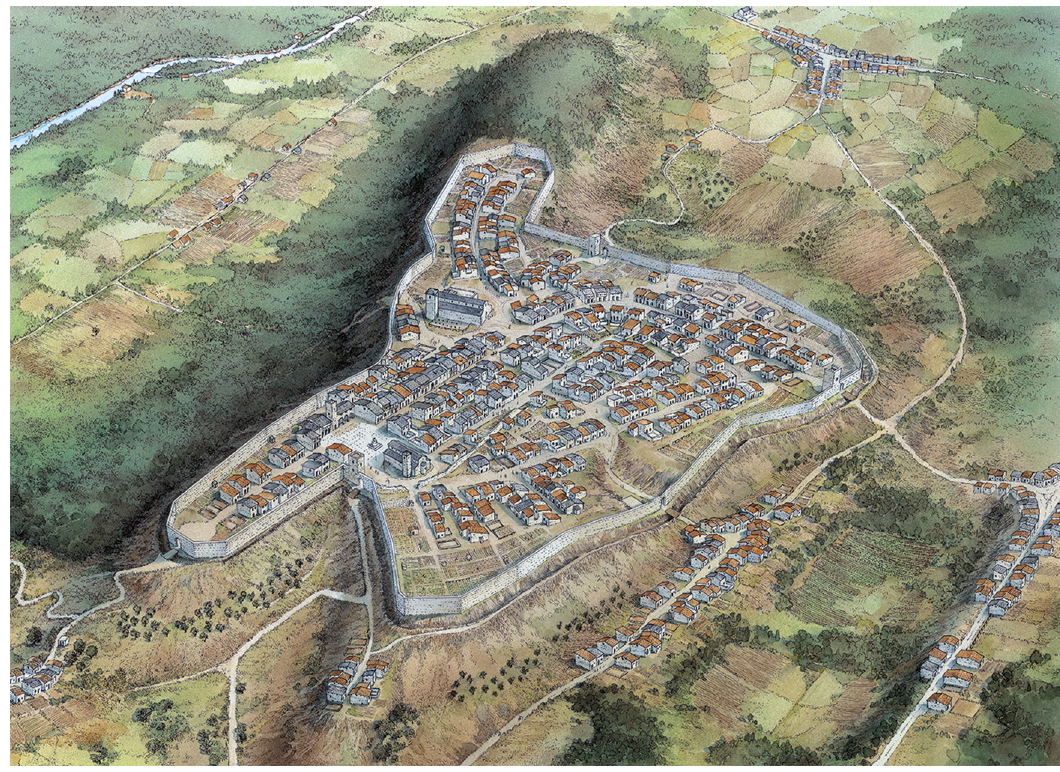
Figure 2: Graphic reconstruction of Podium Bonizi ( Ink Link Studio – Cultural Heritage Communication & University of Siena )